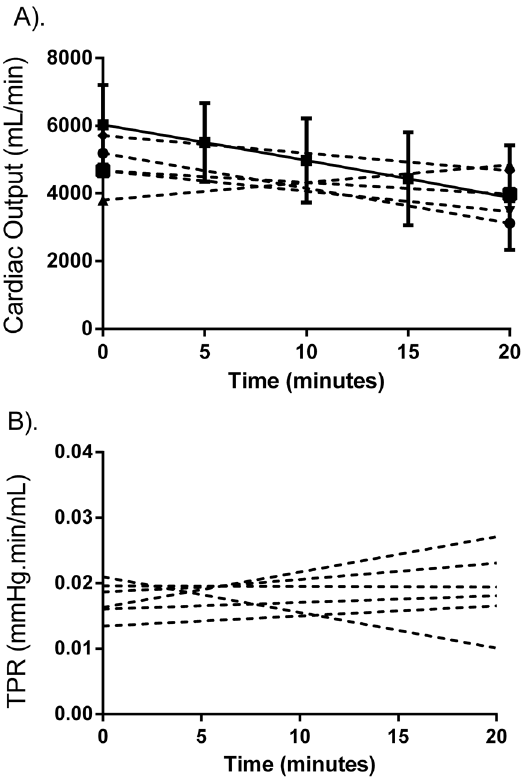
Figure 3. Tracking changes in CO (A) and TPR (B) during hemorrhage. The experimental data (collected at the beginning and end of the hemorrhage only) is not different from model predictions (p , 0.05). The solid lines represent the mean model output, and the dotted lines are taken from Skillman’s report [5]. Error bars represent standard deviation; all experimental values are statistically similar to model output (p , 0.05).